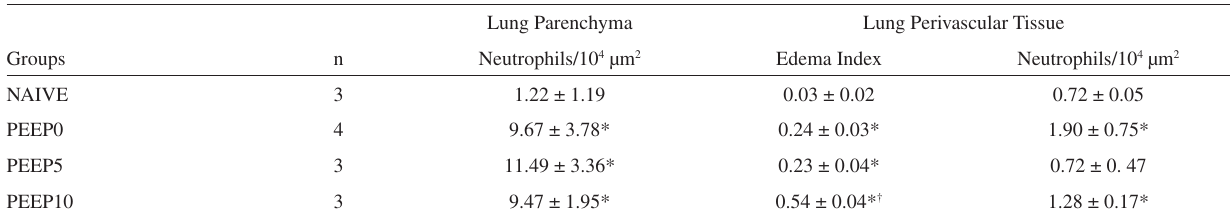
Table 2 - Mean values and standard deviations of neutrophil infiltration and fluid accumulation within pulmonary microves- sels and parenchyma after two hours of mechanical ventilation (*, p<0.05 vs. NAIVE; †, vs. others groups) Lung